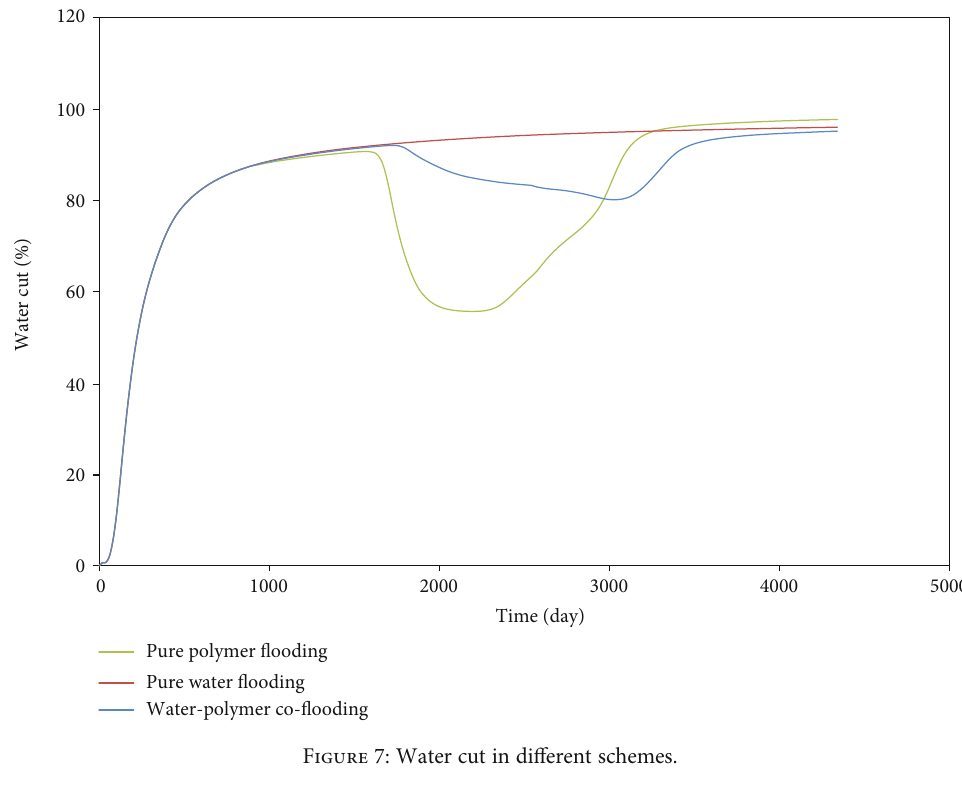
Figure 7: Water cut in di ff erent schemes.